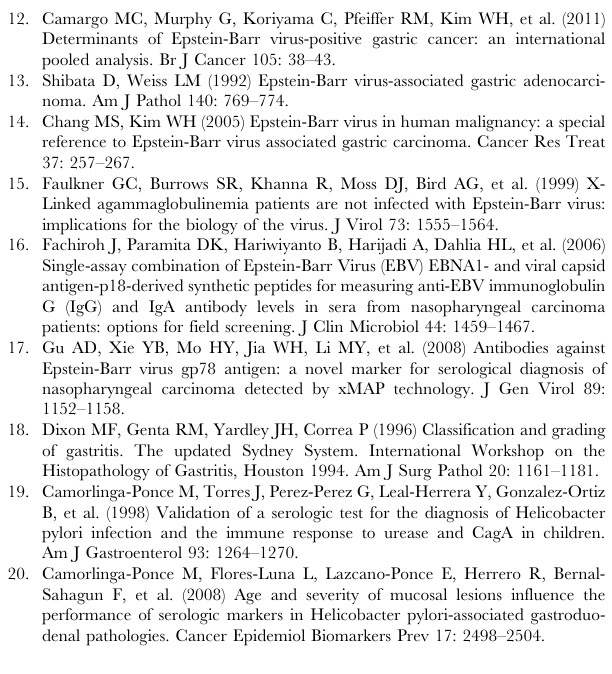
Table S1 Cumulative percentages of cases and H. pylori and EBV seroprevalence. Table S2 Correlation between antibody titers and the gastritis